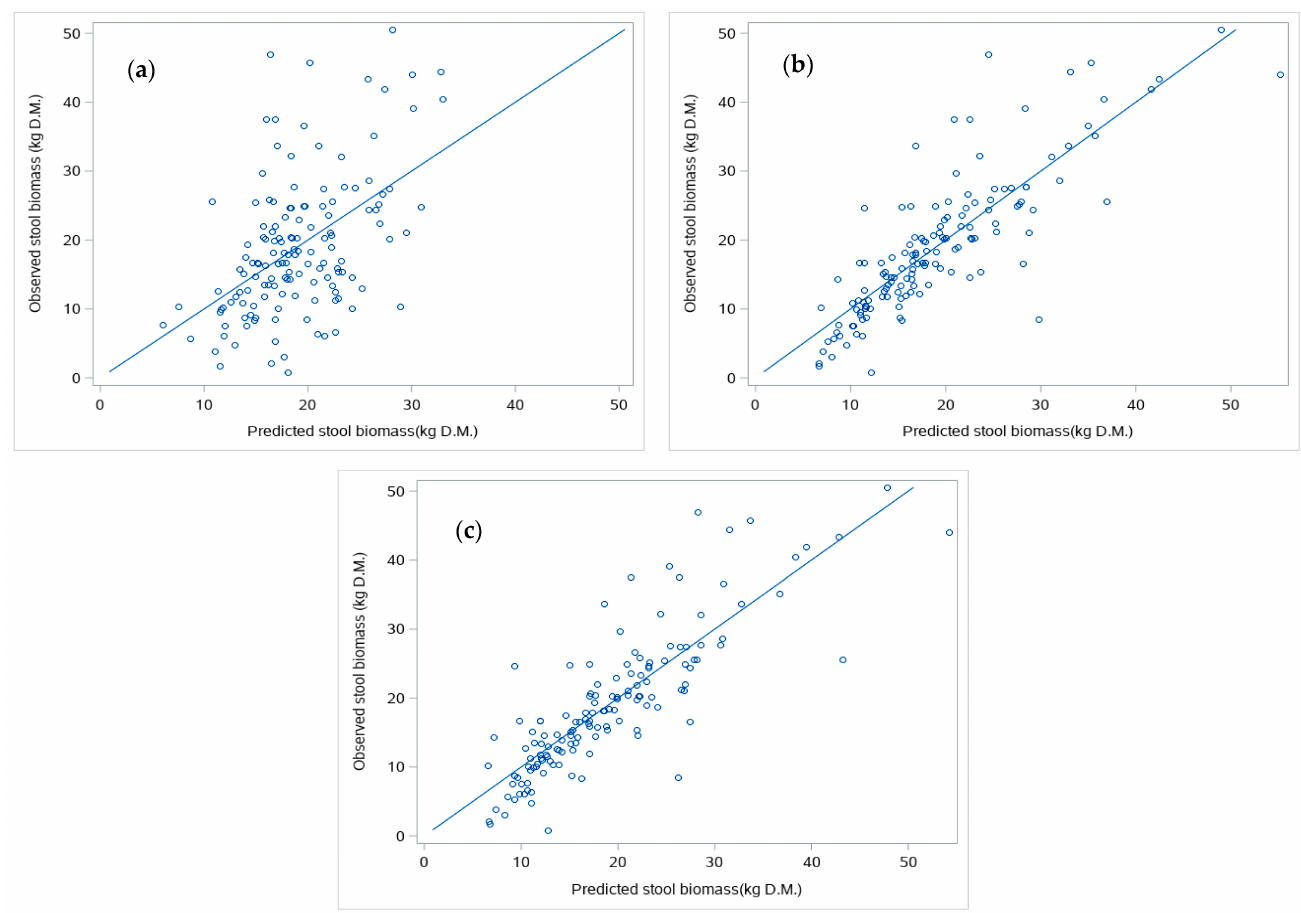
Figure 5. Concordance between observed and predicted values of individual stool biomass for the TLS model ( a ), Field-inventory model ( b ), and combined model ( c ). Straight lines indicate the 1:1.